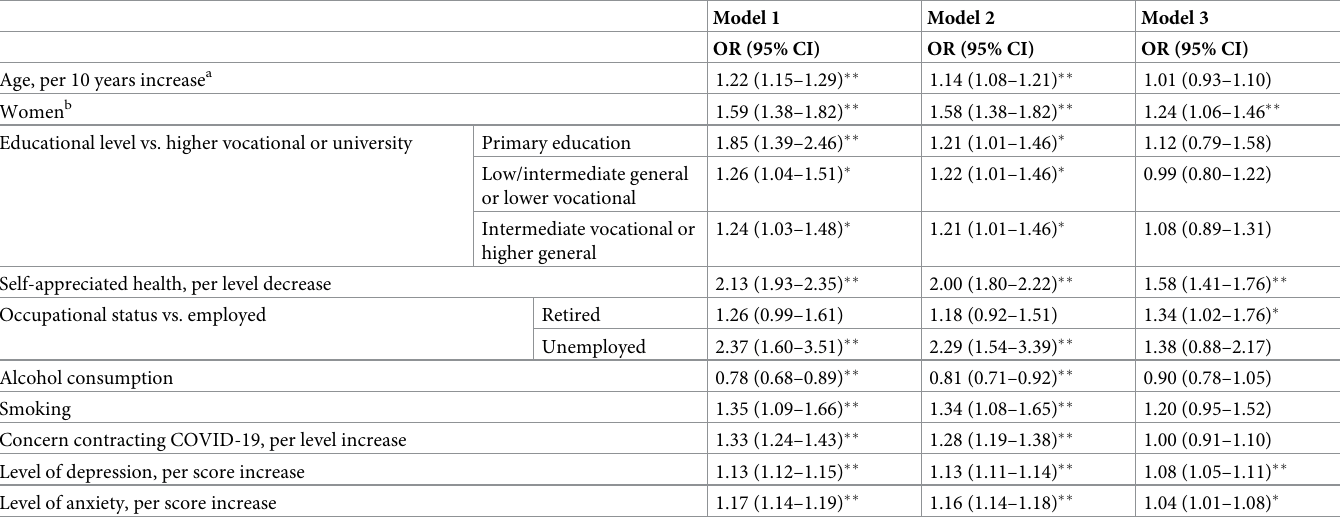
Table 3. Determinants of healthcare avoidance ( N =